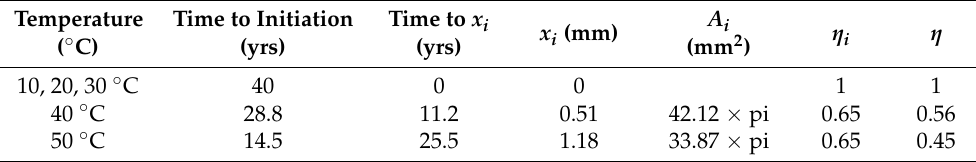
Table 4. Degradation coefficient of piles in service for 40